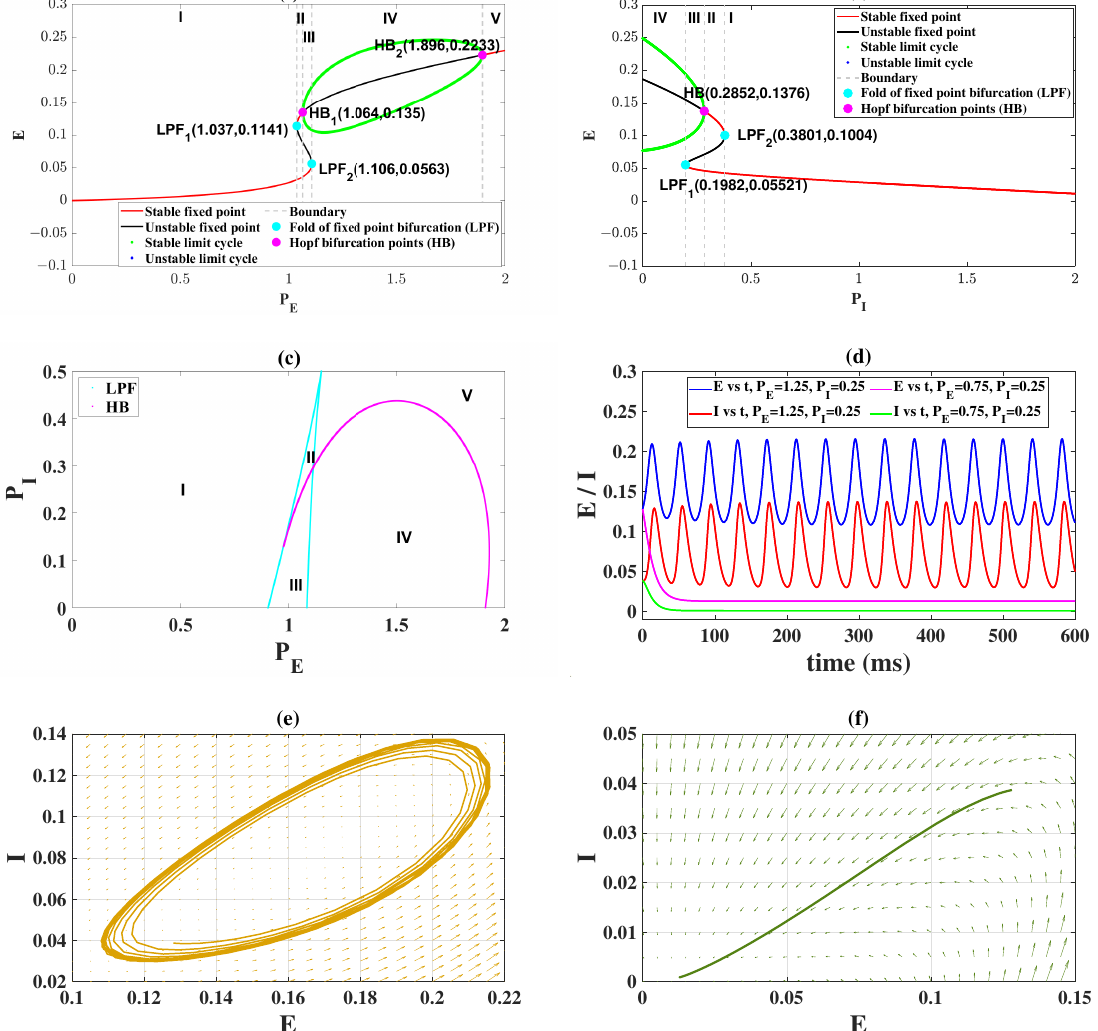
Figure 1. Dynamical bifurcation diagrams induced by P E ( a ) and P I ( b ). Two-dimensional bifurcation diagrams on the plane ( P E , P I ) ( c ). Time series of normal background state and oscillating state by varying P E and P I ( d ). The phase diagram corresponding to the two states: oscillating state ( e ) and normal background state ( f ). The meanings of the symbols are as follows: the low-level stable equilibrium state exists (I), the low-level stable equilibrium state and the medium-level stable equilibrium state coexist (II), the stable limit cycle and the low-level stable equilibrium state coexist (III), the stable limit cycle (oscillating state) exists (IV), the high-level stable equilibrium state exists